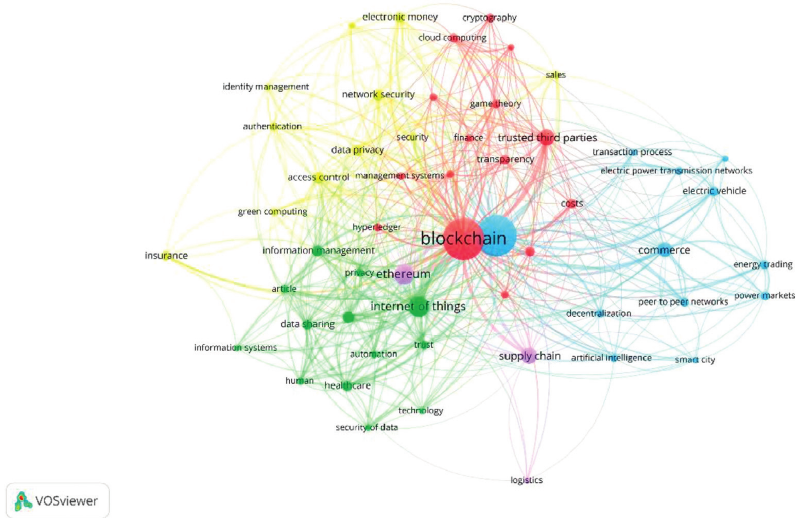
Figure 7: Keywords cooccurrence network. Table 3: Top keywords in smart contracts applications